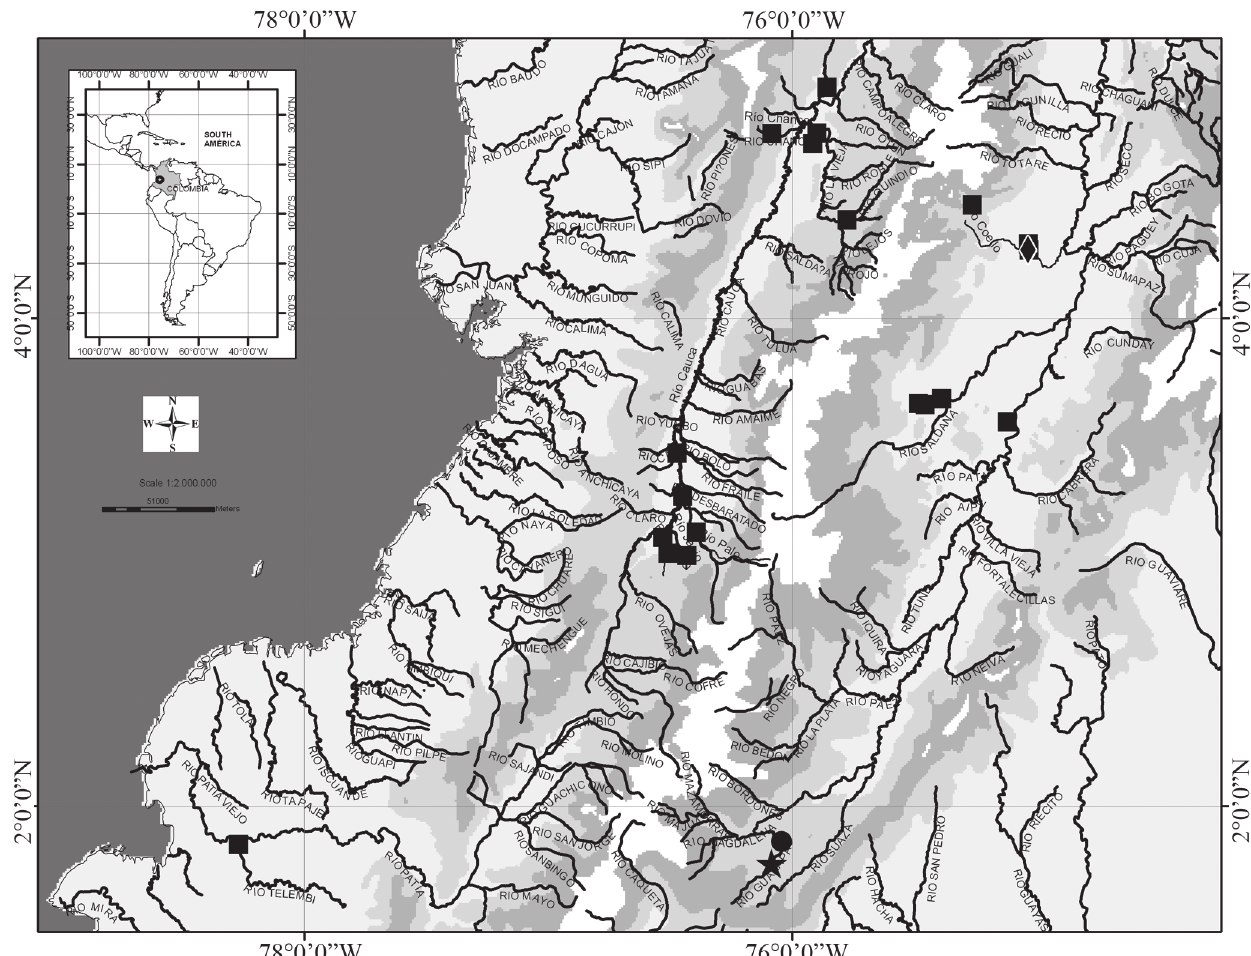
Fig. 2. Map of midwestern region of Colombia showing geographic distribution of Imparfinis timana (circle, star: holotype locality) and I. usmai (squares, diamond: holotype locality). Some symbols represent more than one lot and/or